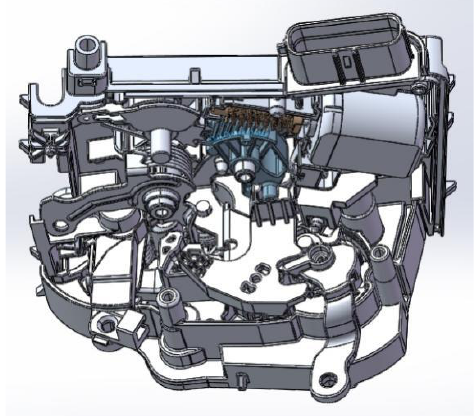
Figure 1. The internal structure model of a light truck door latch.